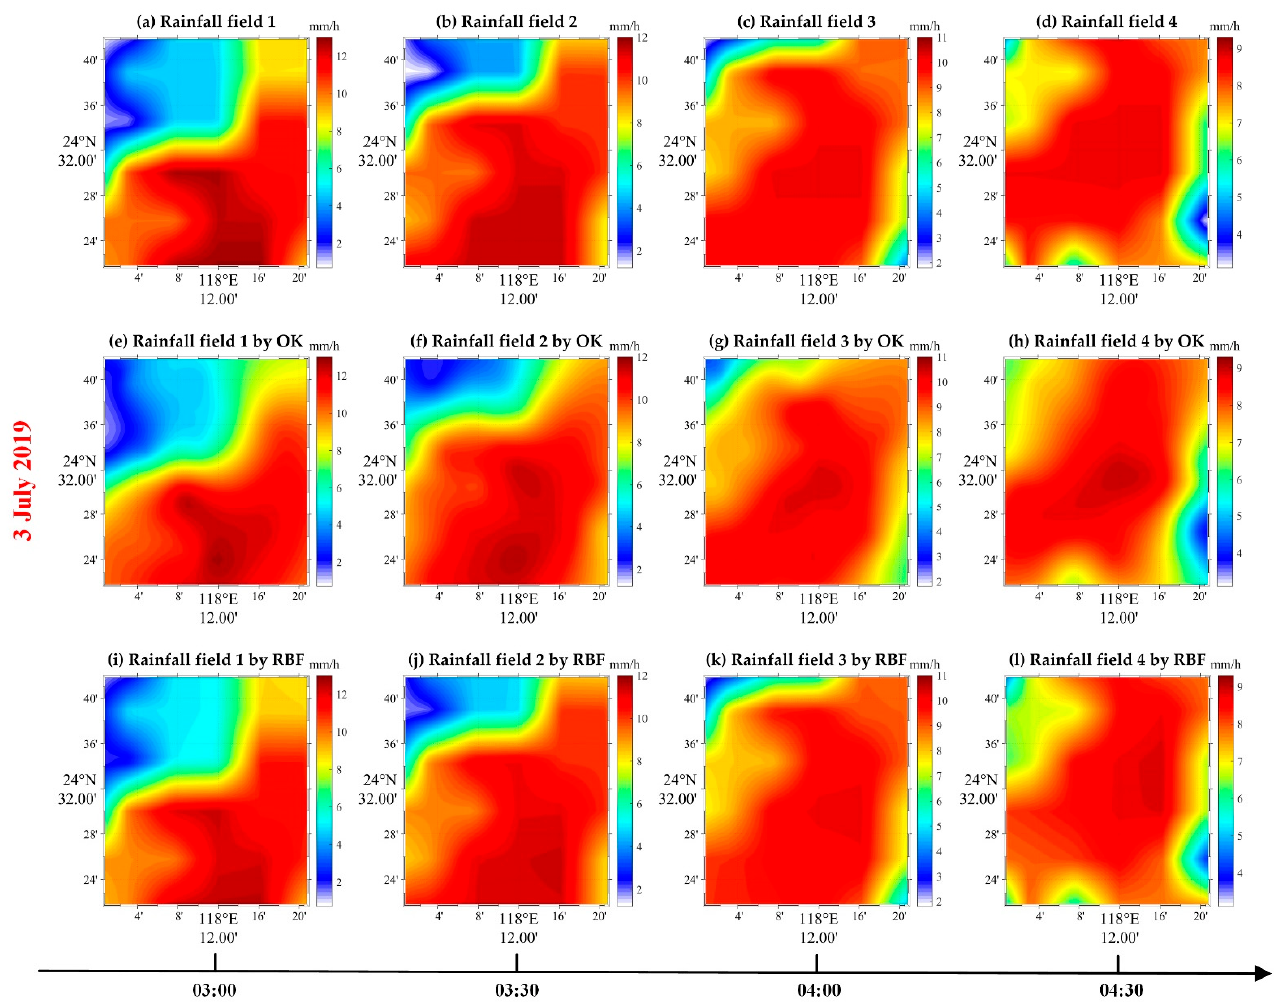
Figure 11. The results of retrieving stratiform rainfall event that occurred on 3 July 2019 by combining ESLs and HMLs. Rainfall field 1 to rainfall field 4 in ( a – d ) show the development of the stratiform rainfall at 0.5 h intervals, characterized by small rain rate, long duration and slow movement. ( e – h ) are the results of retrieving the stratiform rainfall from rainfall field 1 to rainfall field 4 by the OK algorithm, and ( i – l ) are the results of retrieving the stratiform rainfall from rainfall field 1 to rainfall field 4 by the RBF neural network.